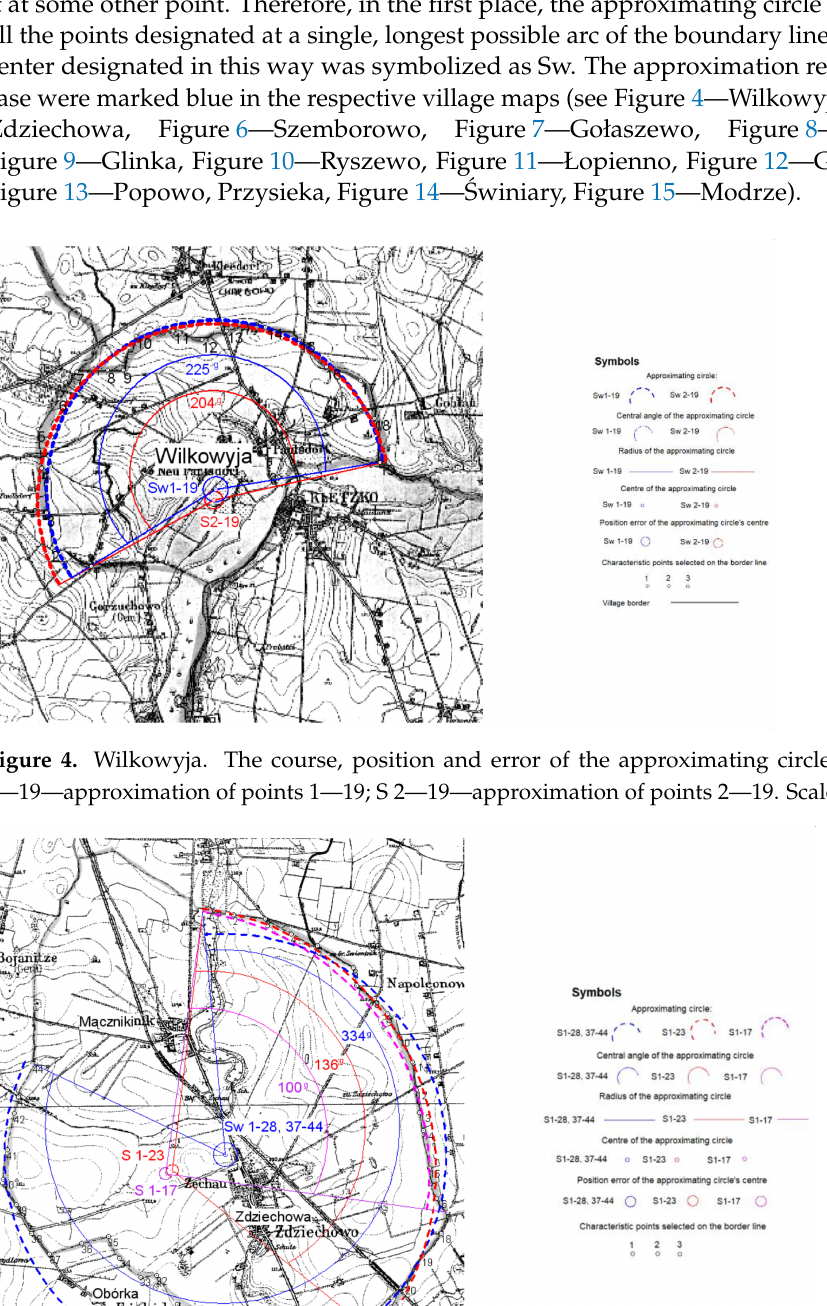
Figure 5. Zdziechowa. The course, position and error of the approximating circle: Sw 1—28,